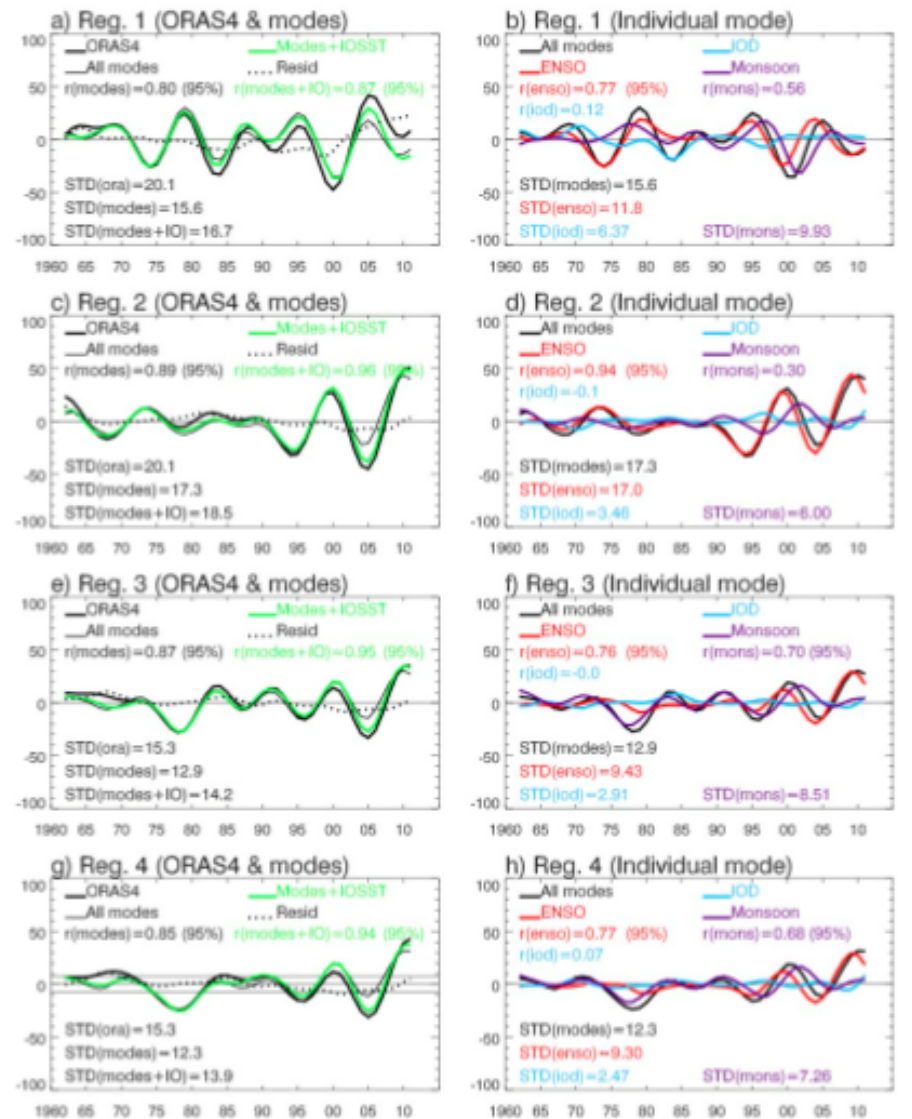
Figure 11. ( a ) The November–April averaged time series of the 8 year low-passed SLA averaged in the thermocline ridge region (Reg. 1 of Figures 6–10) from 1962–2011 from ORAS4 (thick solid black), the sum of climate modes’ effects (ENSO + IOD + monsoon; thin solid black), all modes plus IOSST (green), and residual (black dotted), which is ( ORAS4 − ( all modes + IOSST )); linear trend for 1962–2011 is removed from each curve; ( b ) same as ( a ) except for contributions from all modes (black), decadal ENSO (red), decadal IOD (blue), and decadal monsoon (purple); panels ( c – h ) are the same as ( a , b ) except for the ITF area (Reg. 2 of Figures 6–10), eastern equatorial basin (Reg. 3 of Figures 6–10), and the Bay of Bengal coasts (Reg. 4 of Figures 6–10), respectively. The correlation coefficients r in each panel of the left column are between the observed and DLM simulated SLA from climate modes (black) and climate modes + IOSST (green), and those in the right column show the r between each climate mode and the sum of all climate modes. The two horizontal lines in ( a ) show the ± 0.5 STD of the ORAS4 observed SLA, which serve as a reference for the composites of Section 3.3